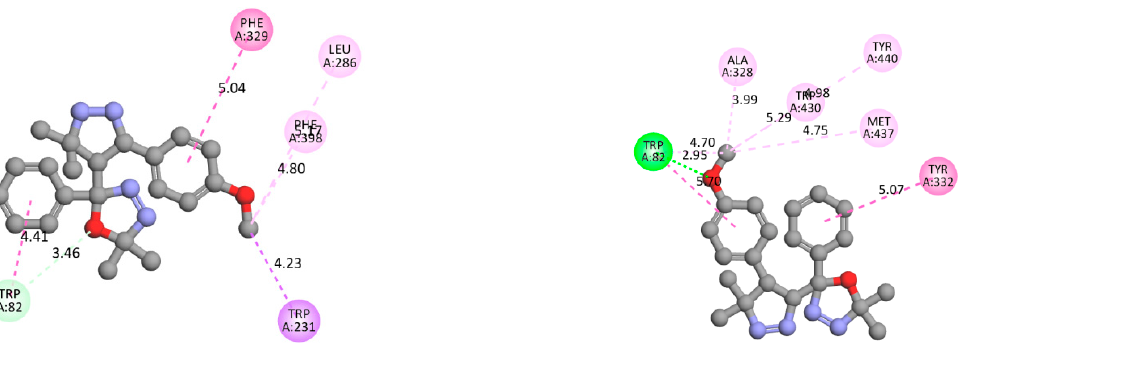
Figure 10. 2D depiction of docking of ligands 1HP14 and 1HP24 in the active site of BuChE (PDB ID: 1P0I).